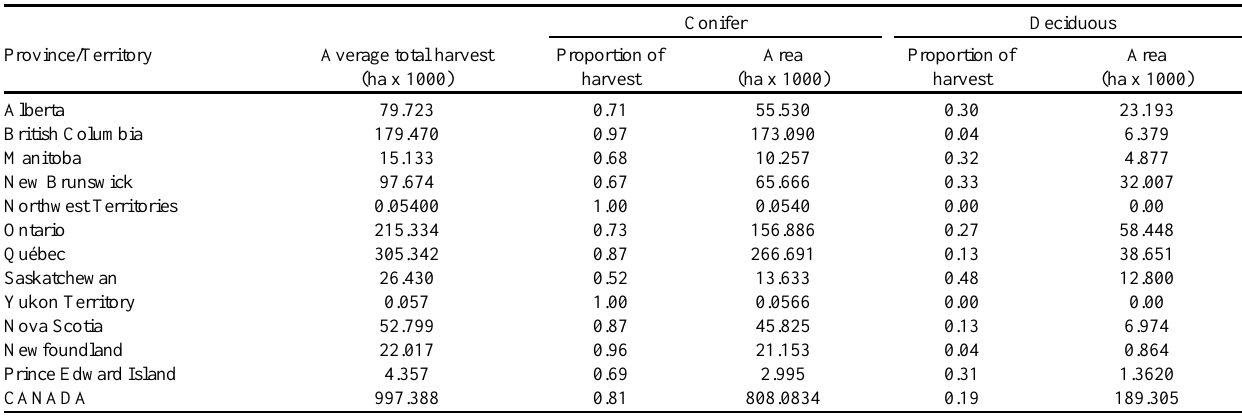
Table 3 . Average annual area of harvest (thousands of hectares) by province/territory, from 2000 to 2006. Proportion conifer and deciduous estimated assuming that these areas were in proportion to timber volumes taken. Forestry statistics were derived from the National Forestry Database (http://nfdp.ccfm.org/dynamic_report/dynamic_report_ui_e.php). Conifer